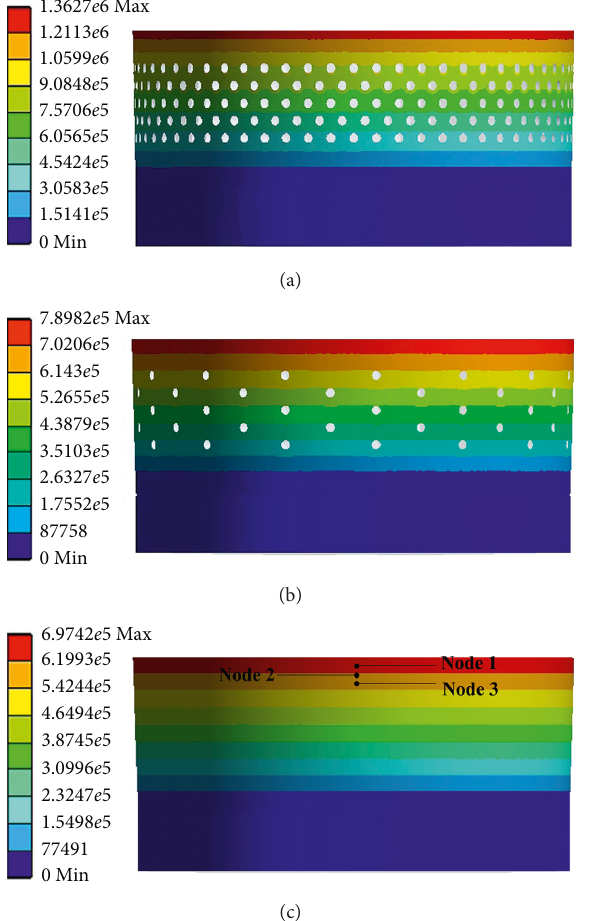
dimpled pistons: (a) L-S1 piston, (b) L-D1 piston, and (c) L- Standard